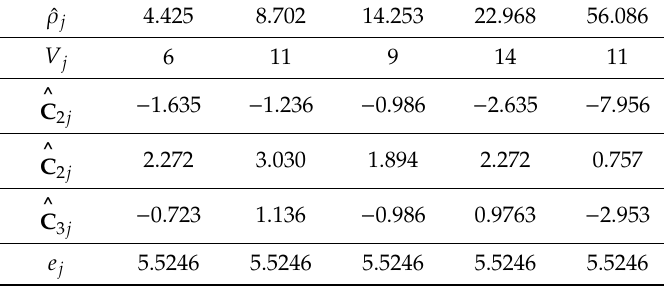
Table 15. Values of the limits ( ˆ ρ j ) , observed numbers of failures ( V j ), and expected numbers of failures ( e j